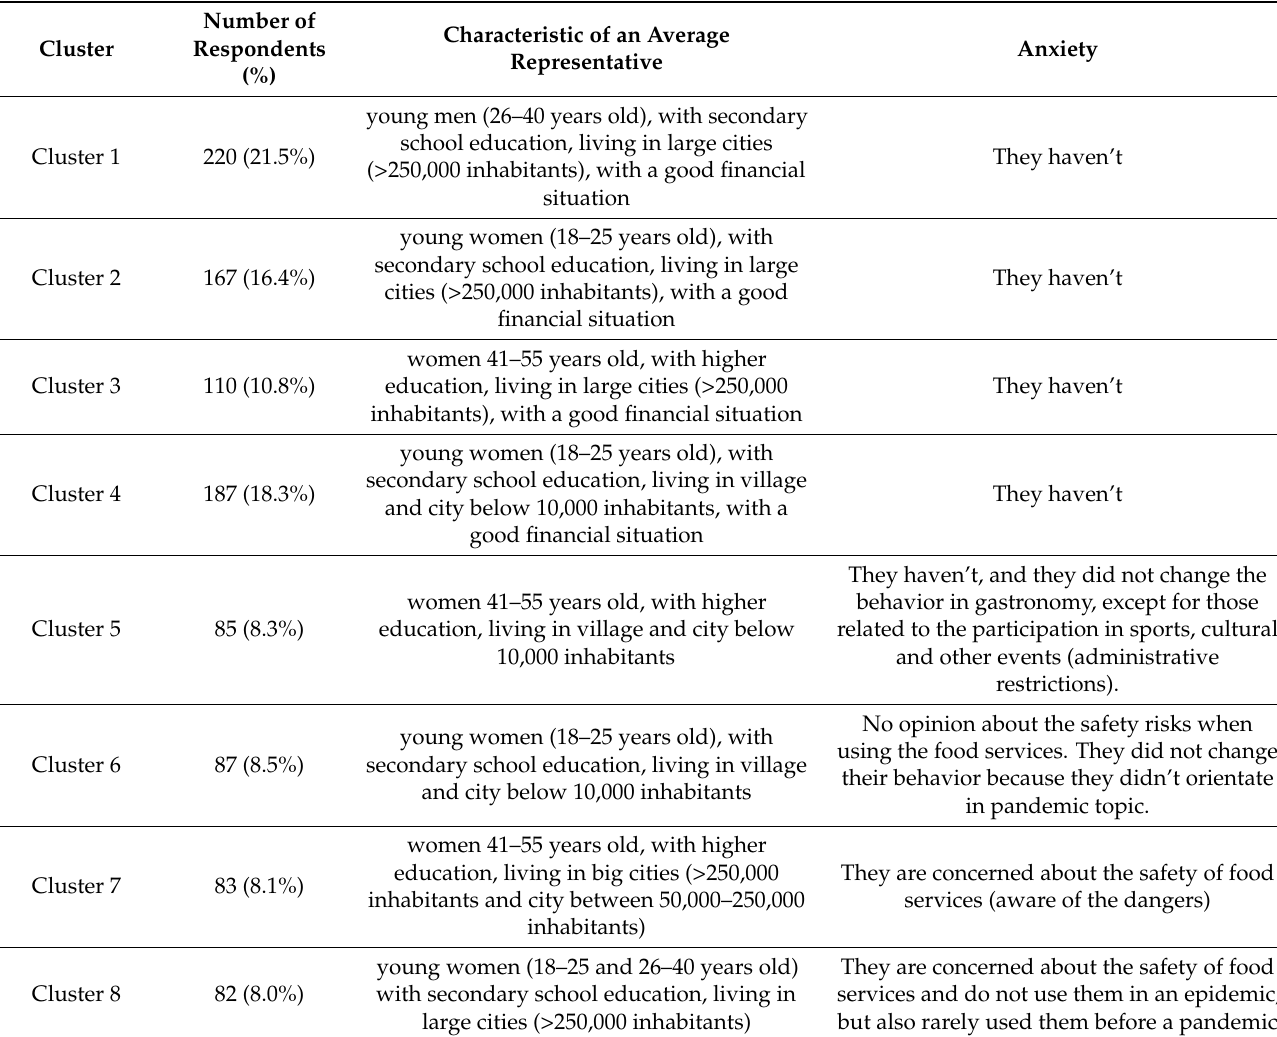
Table 6. Cluster analysis results for consumer anxiety about the use of food services during a pandemic.